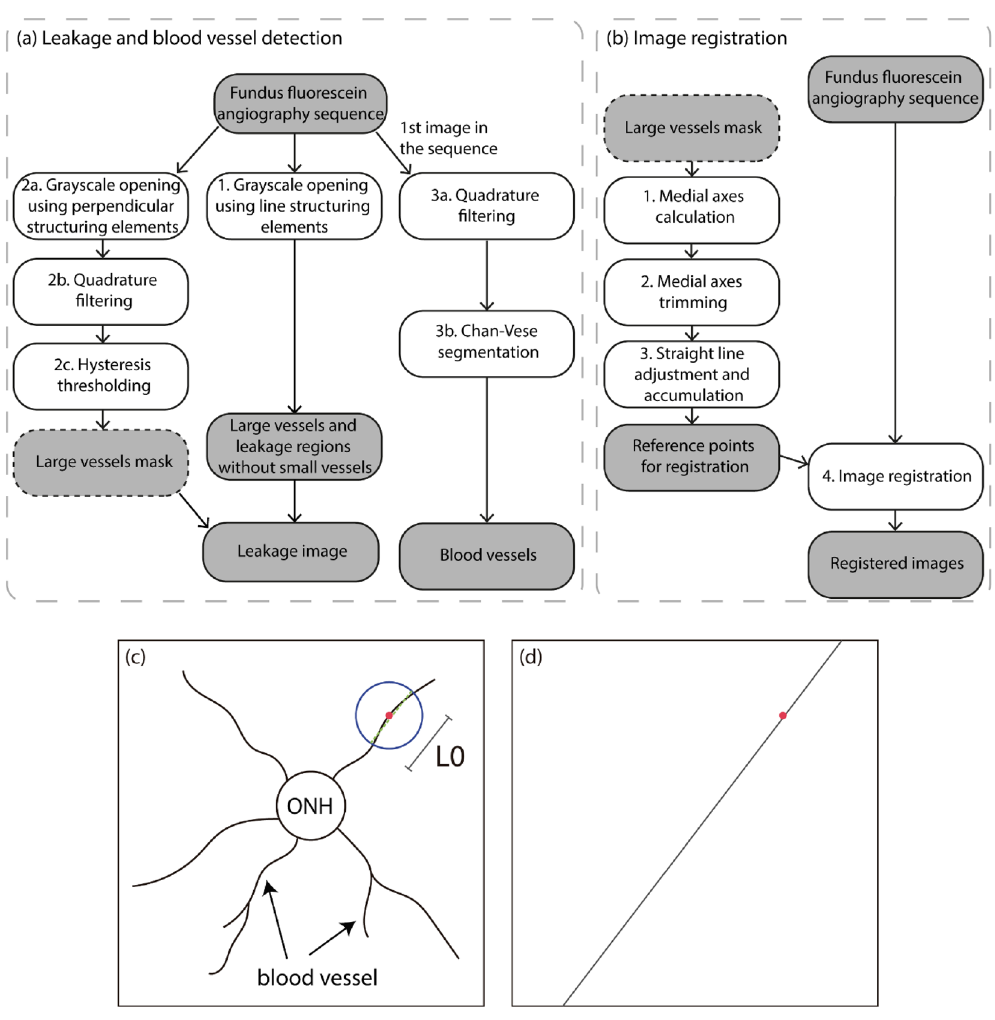
Figure 1. ( a , b ) Flowcharts showing the steps of the proposed methodology for ( a ) detecting leakage regions and blood vessels and ( b ) registering the FFA image sequences. White rectangles indicate processing steps and shaded rectangles indicate the respective resulting images. Note that the large vessels mask image is used as input for image registration. ( c , d ) Illustration of the methodology used for detecting a stable point inside the optic disk. ( c ) Linear regression applied to the neighborhood of a pixel (red point) in the medial axis of a blood vessel. The pixels used in the calculation are those inside the top circle. The dashed line in top circle indicates the obtained line. ( d ) The line is drawn in the accumulator array. The dot indicates the original point for reference. ONH: optic nerve head; L 0 defines a scale of analysis for applying the linear